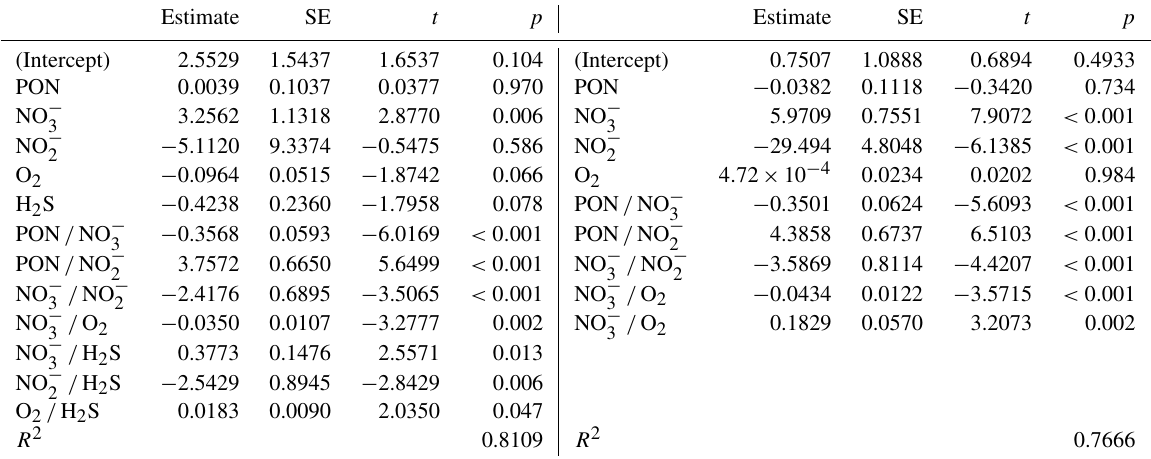
Table 3. Multiple linear regression statistics (standard error – SE; t and p values), describing denitrification in response to various environ- mental variables, for the best five-variable model (in terms of R 2 ), with interactions (compare Fig. 5c), and the best four-variable model.